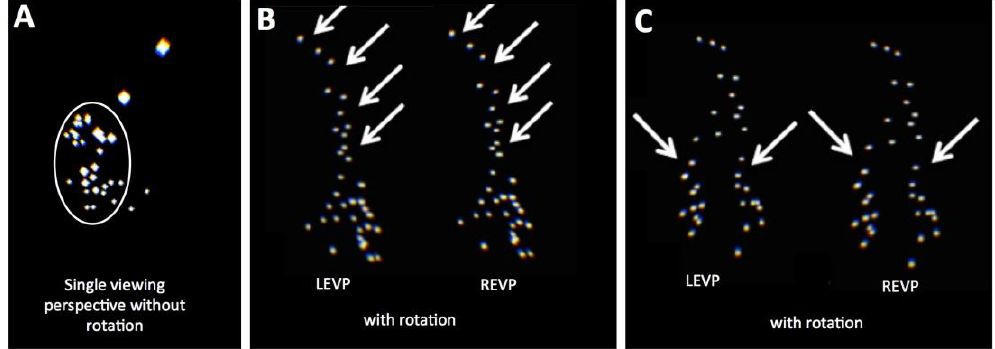
Figure 6. Images of simulated breast microcalcifications [15]. ( A ) Illustrates single projection viewing of the simulated breast microcalcifications as a cluster (false negative). ( B ) Illustrates viewing of the same breast microcalcifications with the VR D3D system with rotation. Note that there are two images, one of which shows the left eye viewing perspective (LEVP) and the other shows the right eye viewing perspective (REVP). Note that this illustrates a linear pattern, which is more suspicious for ductal carcinoma in situ (DCIS), a form of breast cancer. ( C ) Illustrates viewing of the same breast microcalcifications with the D3D system with rotation. Note the linear and branching pattern, which is most concerning for DCIS. This was classified as a true positive. Reprinted from Journal of Medical